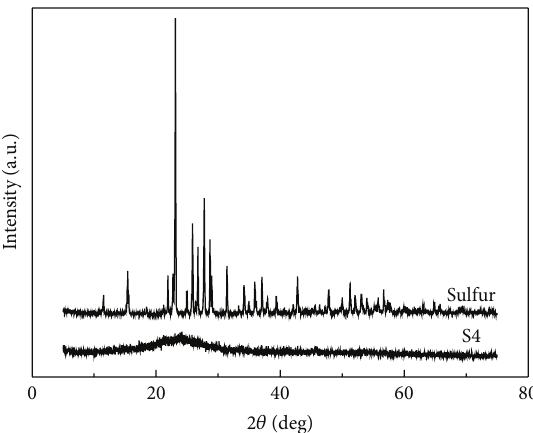
Figure 5: XRD patterns of element sulfur and